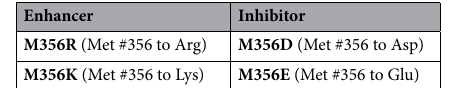
Table 8. Methionine (Met/M) amino acid mutants.